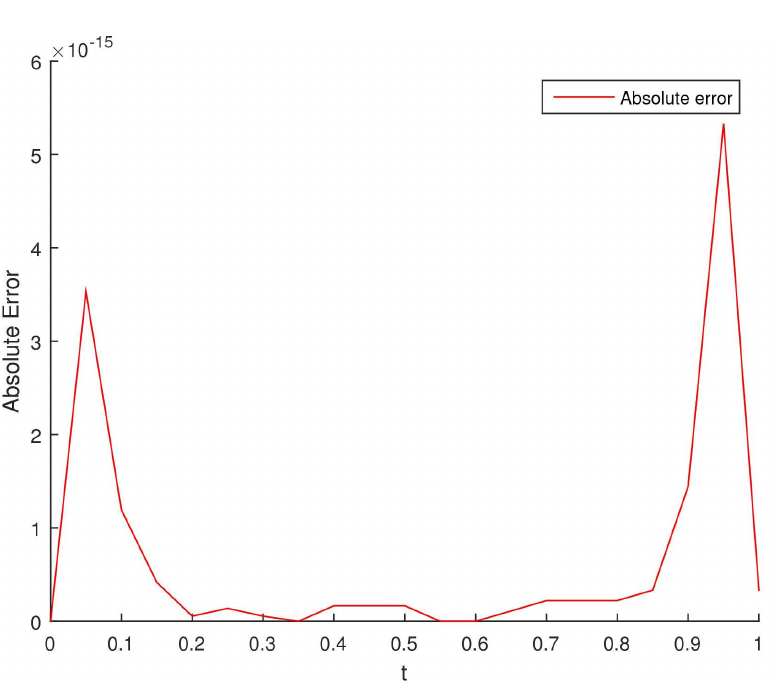
Figure 17. The compared results of the approximate and exact solutions for Example 6 in the interval